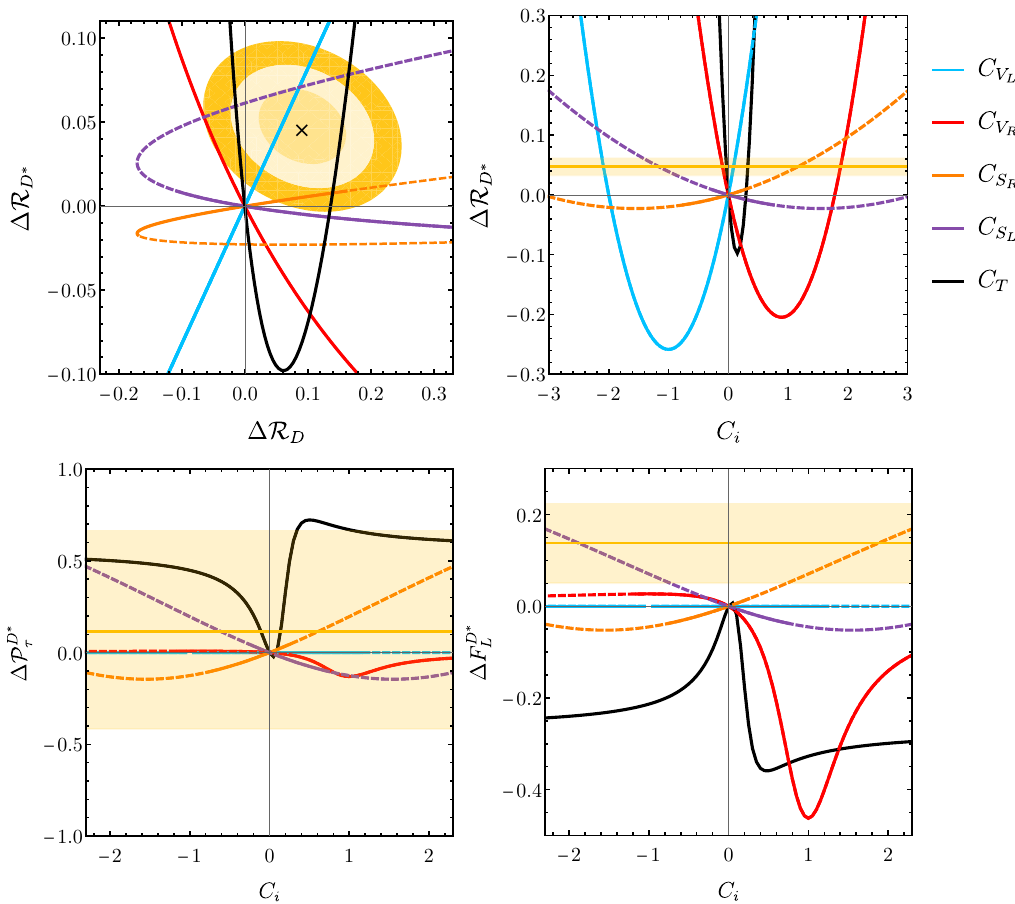
Figure 6 . Individual contributions of the Wilson coefficients of the WET Hamiltonian in different observables (∆ X X X SM ): correlation between ∆ ≡ − D ∗ as a function of the Wilson coefficients. Left-top panel: the experimental central value is ∆ L F denoted by a black cross and the 1 σ, 2 σ and 3 σ uncertainties by yellow rings. Right-top and bottom panels: experimental central values are displayed by a solid yellow line and their 1 σ uncertainty by a yellow band. Dashed lines indicate regions excluded by the constraint